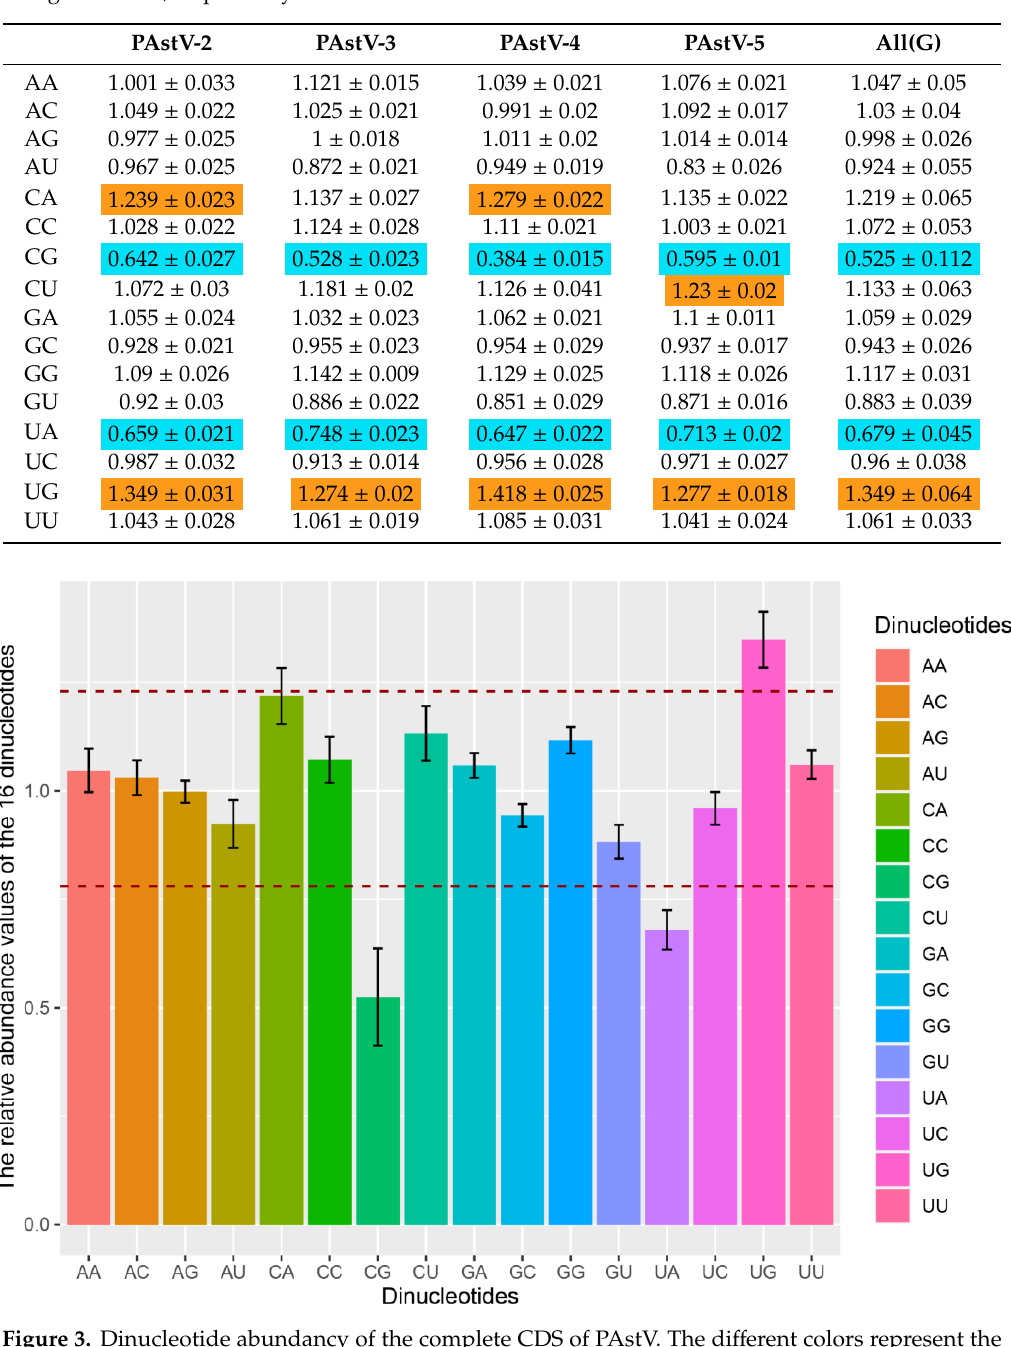
Table 3. Relative dinucleotides frequencies of CDS of PAstV strains. The odds ratios of over-represented ( ≥ 1.23) and the under-represented ( ≤ 0.78) dinucleotides are highlighted using orange and blue, respectively.